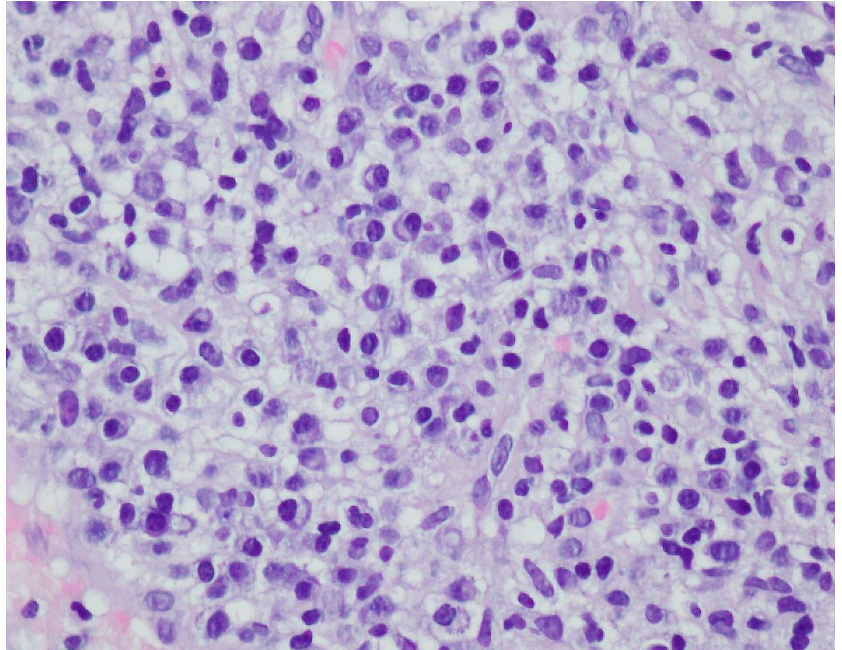
Figure 9. Thickened non-regular epidermis with streaky swelling, thinned by lymphocytic and histiocytic inflammatory infiltration with single plasmacytes. Slightly thicker infiltration in the area of enlarged vessels of the superficial plexus. Lack of characteristics typical for active pyoderma gangrenosum. The clinical picture can be consistent with secondary/tertiary syphilis. A revision of the biopsy from September 2021 showed a thickened epidermis and lympho- cytic and histiocytic inflammatory infiltration with multiple plasmacytes (Figures 10 and 11).